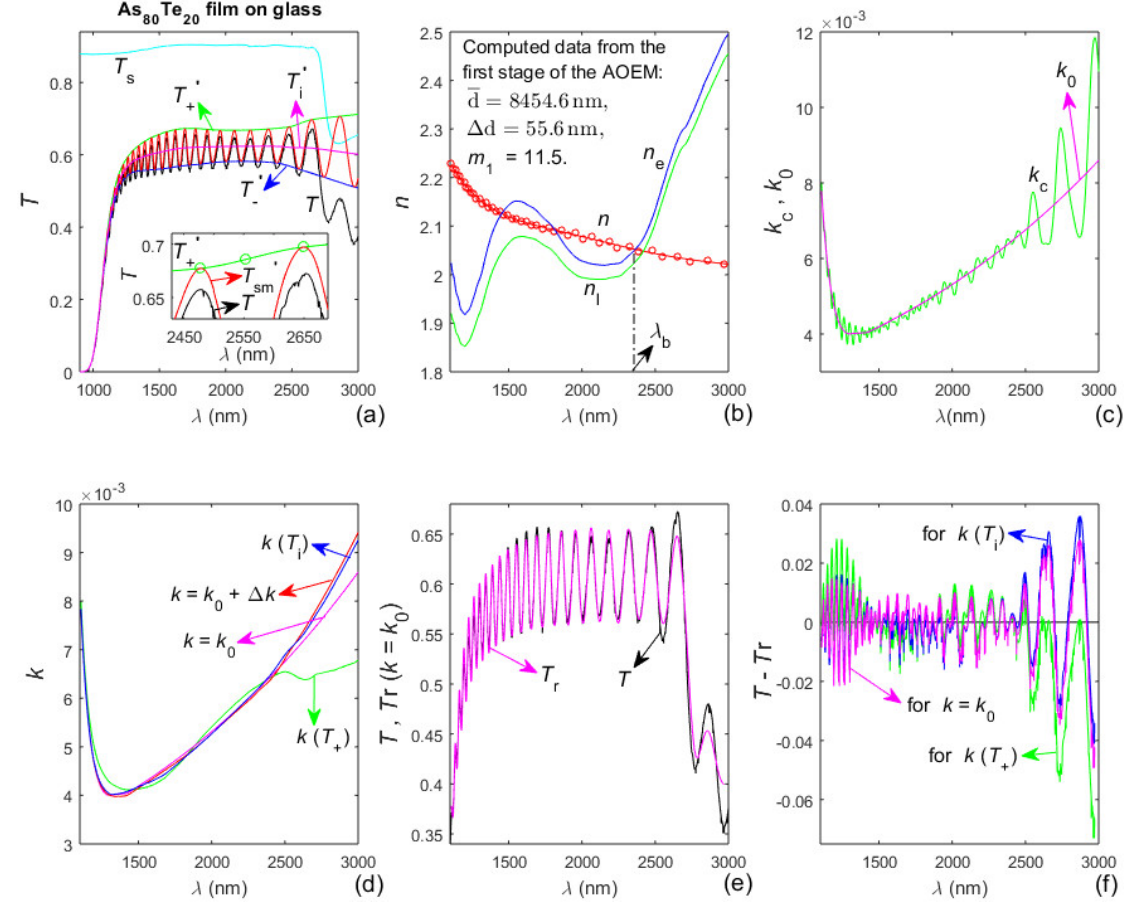
Figure 5. Input data and computed results from the characterization of the As 80 Te 20 film by the AOEM. ( a ) T s ( λ ), T ( λ ), T sm ( λ )’, its envelopes T + ( λ )’ and T − ( λ )’, and T i ( λ )’; ( b ) n 0 ( λ t ), n ( λ ), n l ( λ ) and n e ( λ ); ( c ) k c ( λ ) and its optimized curve fitted k 0 ( λ ); ( d ) k ( T + ) computed from Equation (2), k ( T i ) from Equation (8) and k = k 0 + ∆ k ; ( e ) T ( λ ) and the reconstructed spectrum T r ( λ ) computed using k = k 0 ; and ( f ) difference between T ( λ ) and T r ( λ ) with k = k 0 , k ( T + ) and k ( T i ).